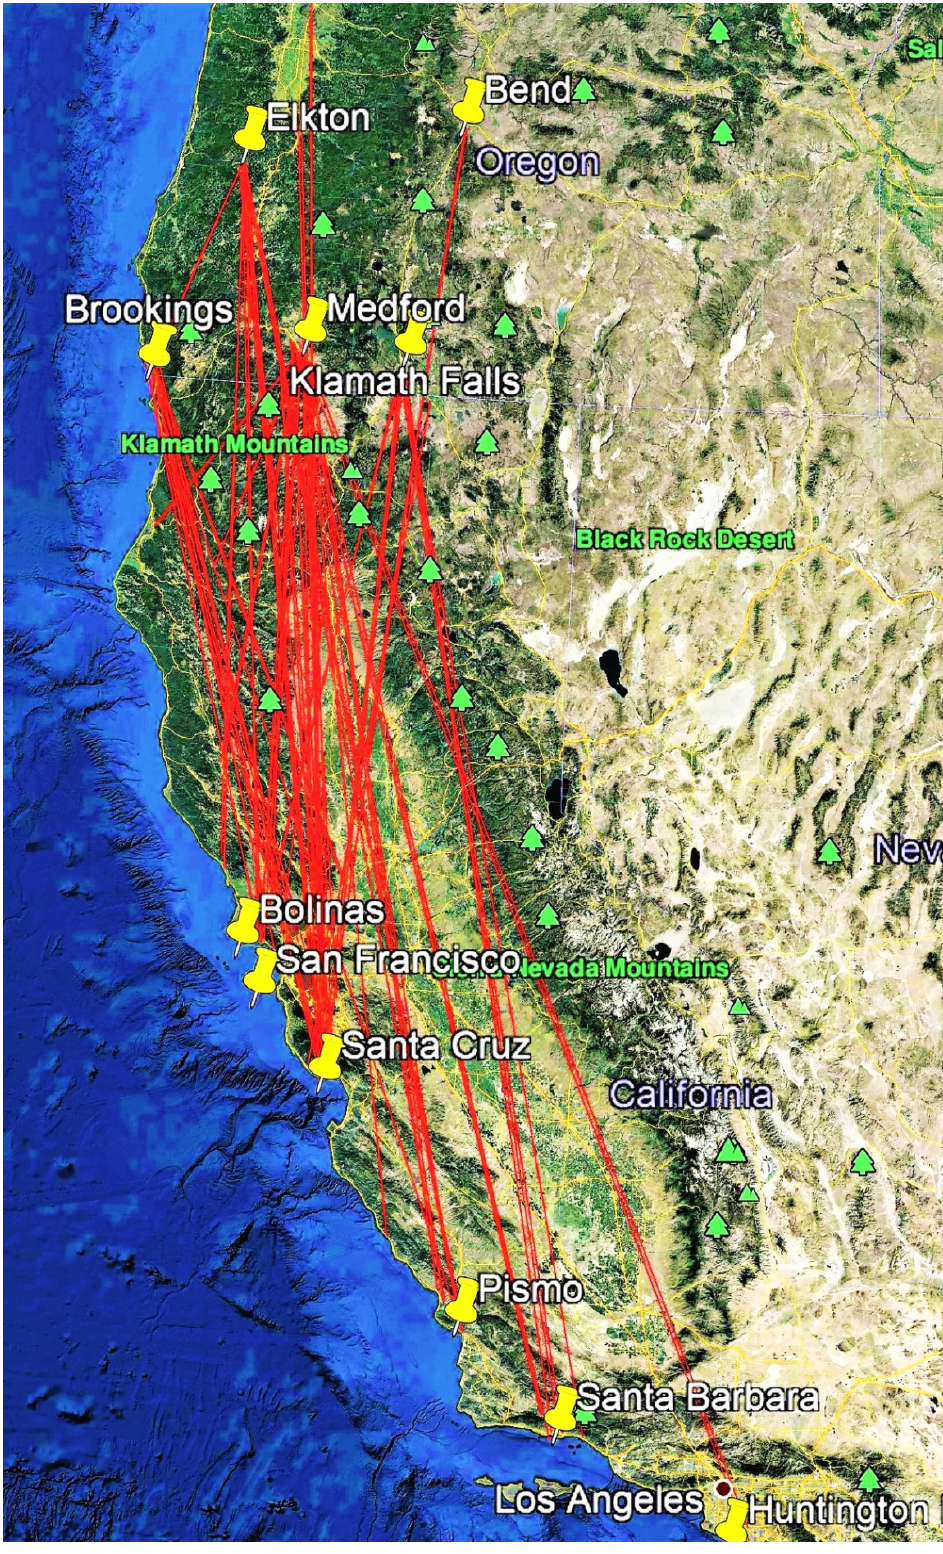
Figure 3. Release–recovery lines (N to S) for captive-reared tagged monarchs released in Oregon during 2017–2019.